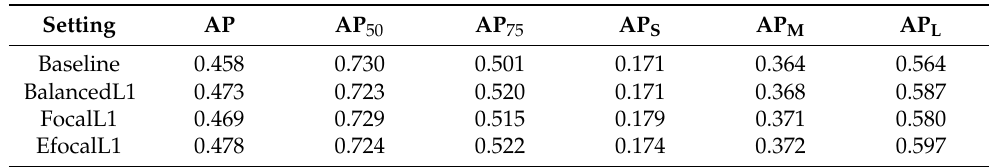
Table 2. Ablation studies of the EfocalL1 loss on MOCS.